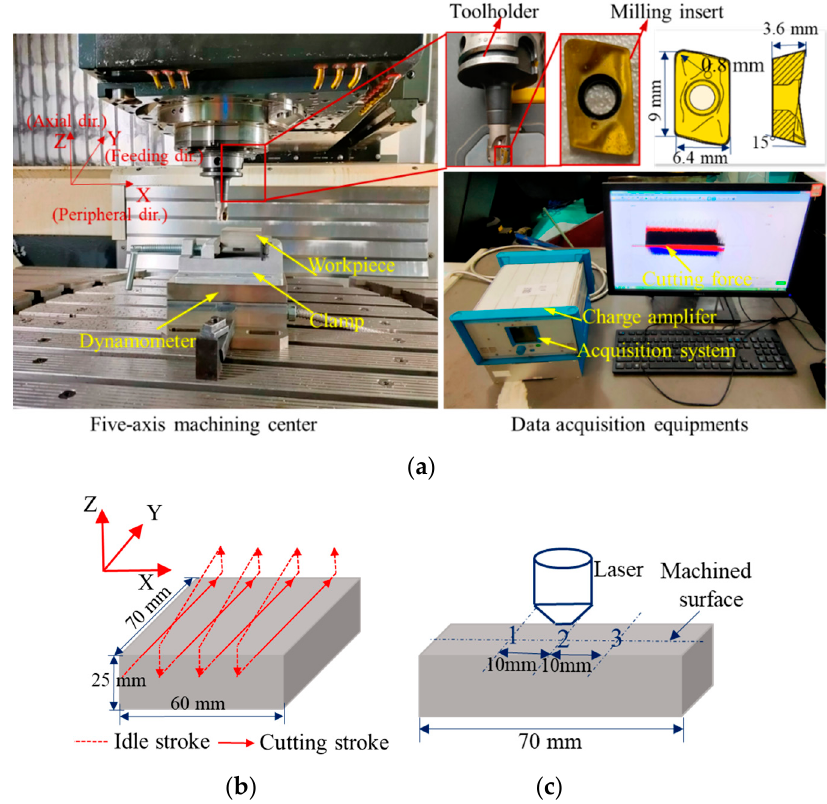
Figure 5. Experimental setup and data acquisition. ( a ) The actual diagram of experimental setup; ( b ) The tool path of cutting; ( c ) The measurement position of surface topography.